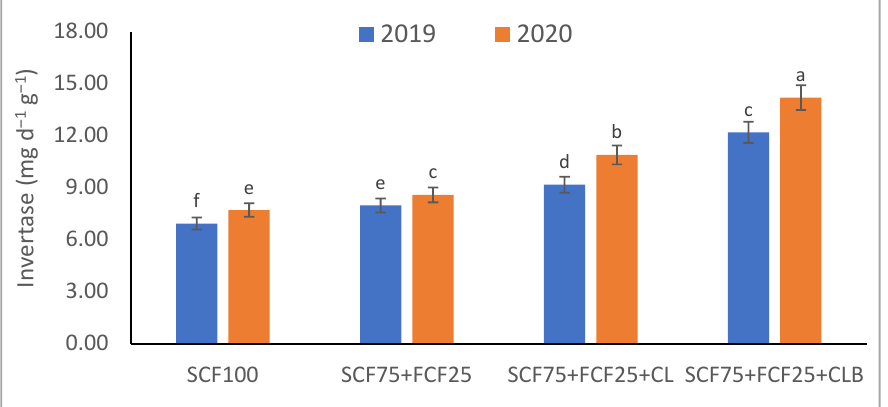
Figure 3. Response of soil enzyme activities (cellulase) to different fertilization strategies applied in two seasons (2019 and 2020) to sandy soil. Abbreviations of fertilization treatments are explained in Table 1. Bars with a different letter indicate significant difference between treatments at p ≤ 0.05.